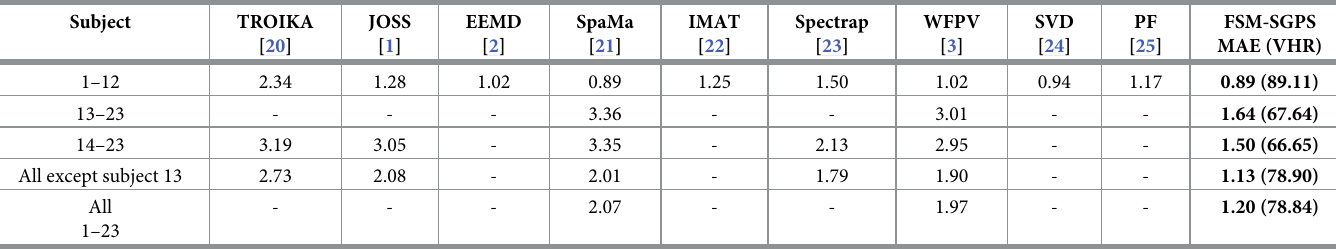
Table 4. Comparison of MAEs of various HR estimation methods for the ISPC